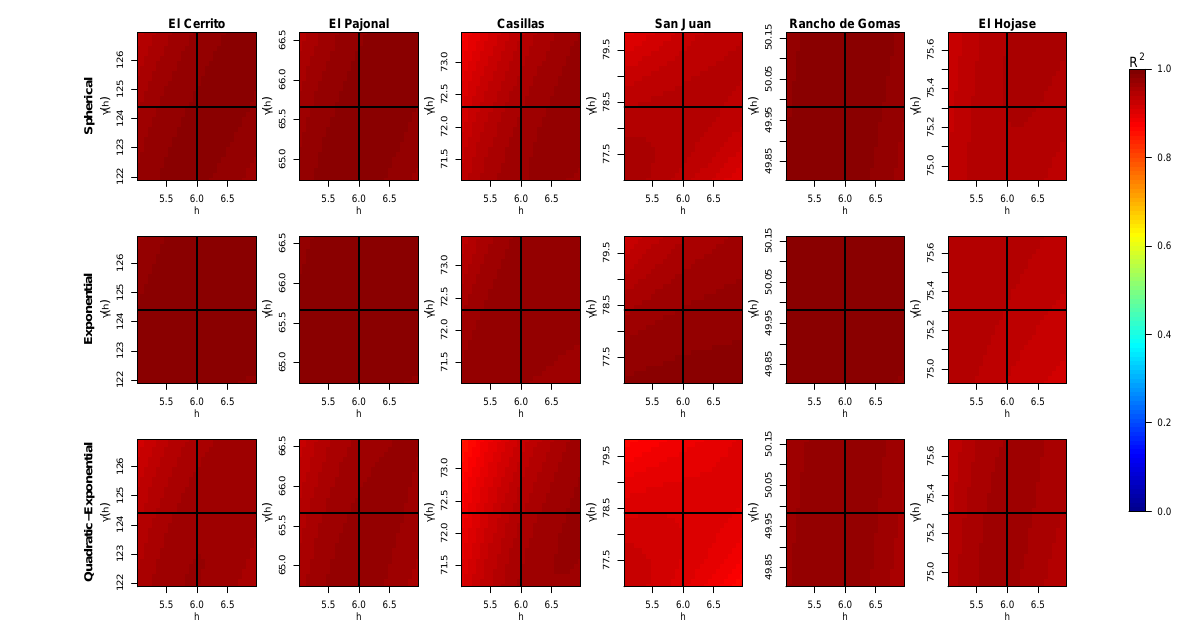
Figure A2. Obtained values of R 2 (color bar) for different pair of data ( r , γ ( r )) when fitting a curve for the variogram of each station with the three models and considering the nugget effect. The intersection of the black solid lines tags the real position ( r , γ ( r )) .